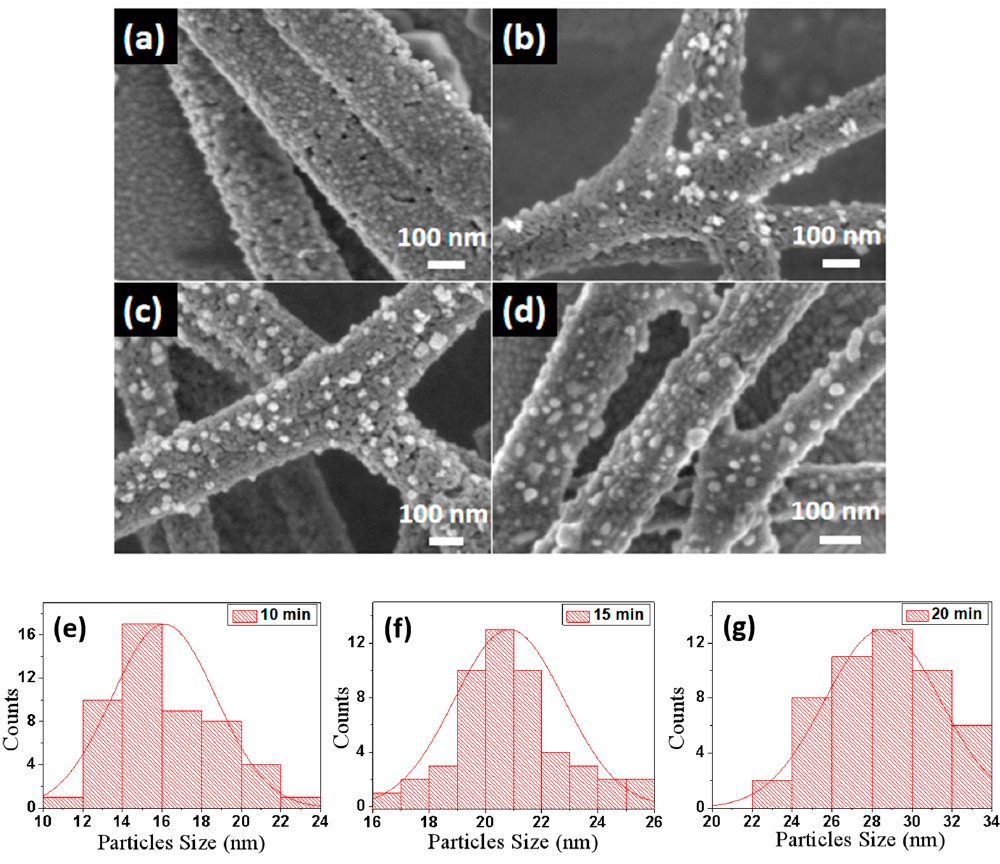
Figure 3. ( a – d ) FE ‐ SEM images of Au/TiO 2 NFs with UV irradiation times of 5, 10, 15, and 20 min, respectively. ( e – g ) Diameter distribution of Au NPs measured for ( e ) 10 ‐ Au/TiO 2 NFs, ( f ) 15 ‐ Au/TiO 2 NFs, and ( g ) 20 ‐ Au/TiO 2 NFs, from corresponding SEM images ( b – d ). Transmission ‐ electron ‐ microscopy (TEM) measurements were performed to further investigate the grown Au/TiO 2 crystals. Figure 4a depicts a low ‐ magnified TEM image of the 15 ‐ Au/TiO 2 NF sample. It shows that Au NPs were homogeneously deposited on the TiO 2 NFs with an average diameter of around 20 nm. The high ‐ resolution TEM (HR ‐ TEM) image in Figure 4b indicates the contact region between the crystal structure of the TiO 2 NFs and Au NPs. Additionally, the image demonstrates the single crystalline atomic arrangements of TiO 2 and Au in which the lattice fringes